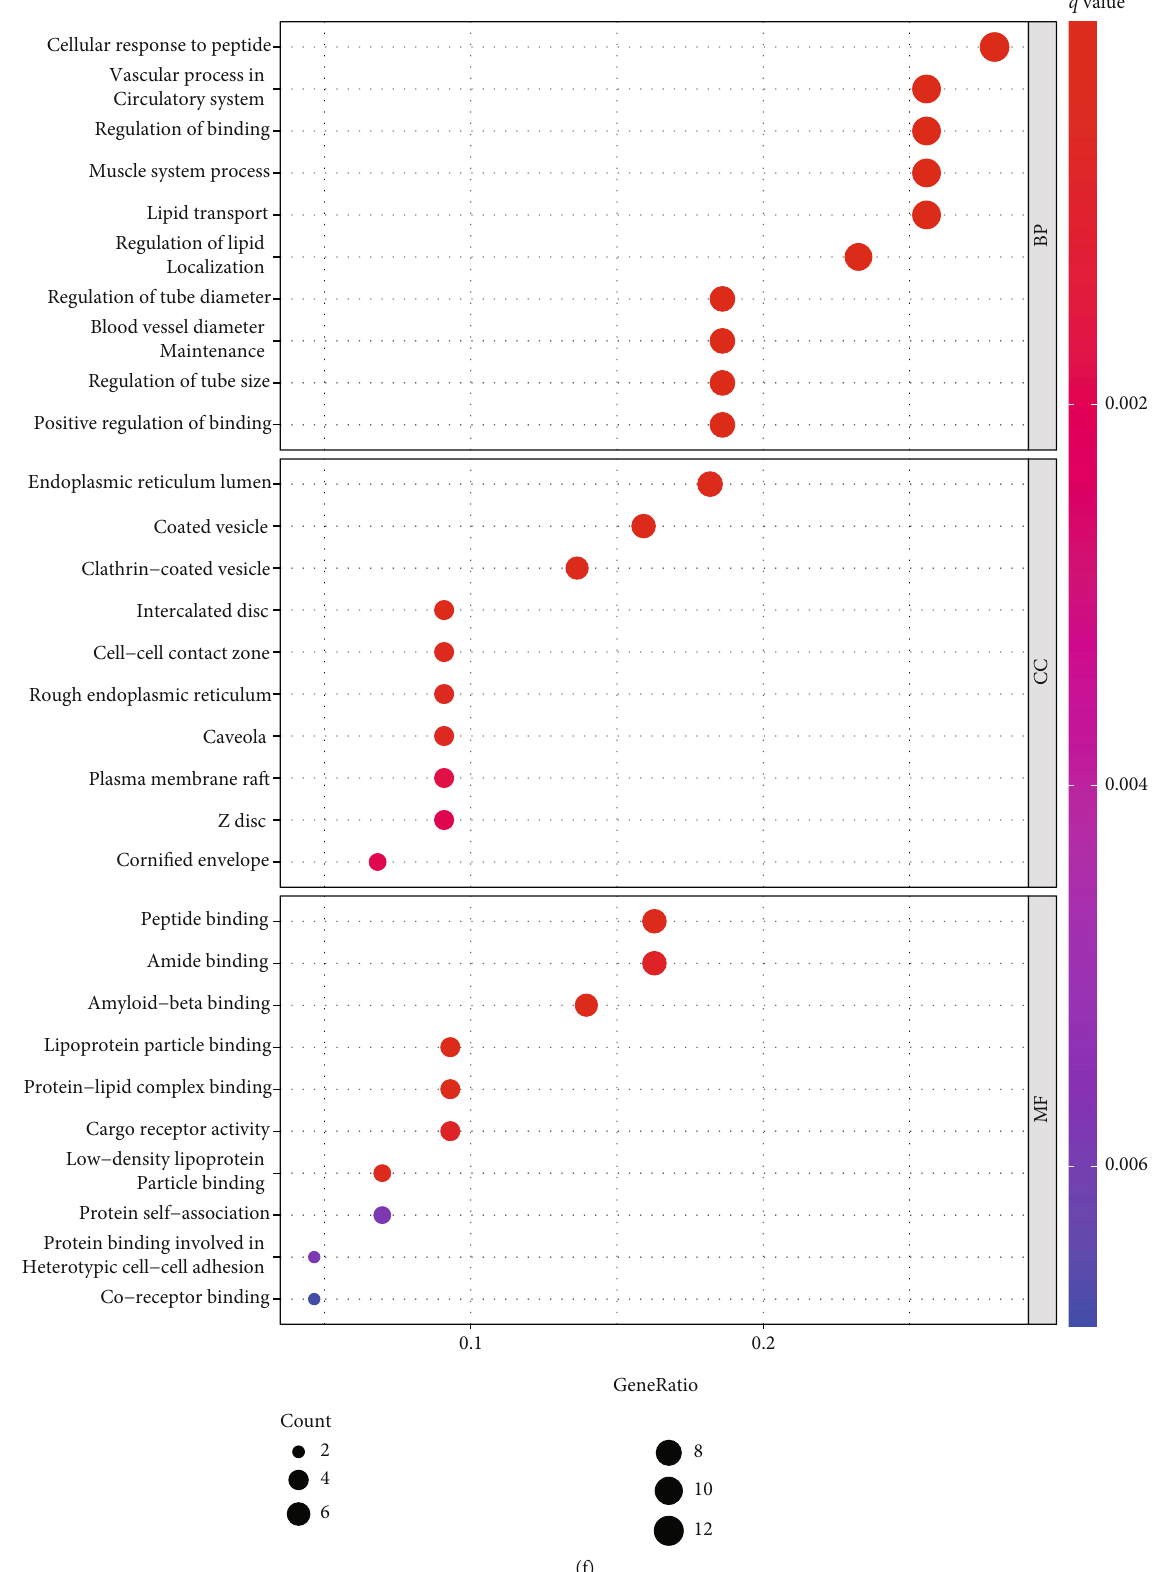
Figure 2: Total 44 common di ff erentially expressed genes. (a) Venn Diagram. (b) Heatmap. (c) PPI of 44 genes. (d) DO analysis. (e) KEGG analysis. (f) GO